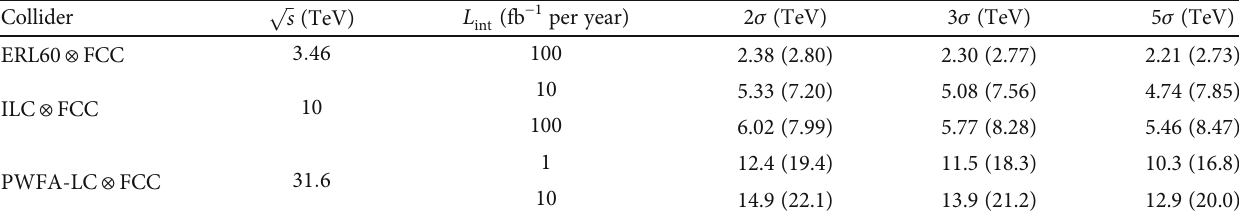
= 1 ð I = 3/2 Þ . W W